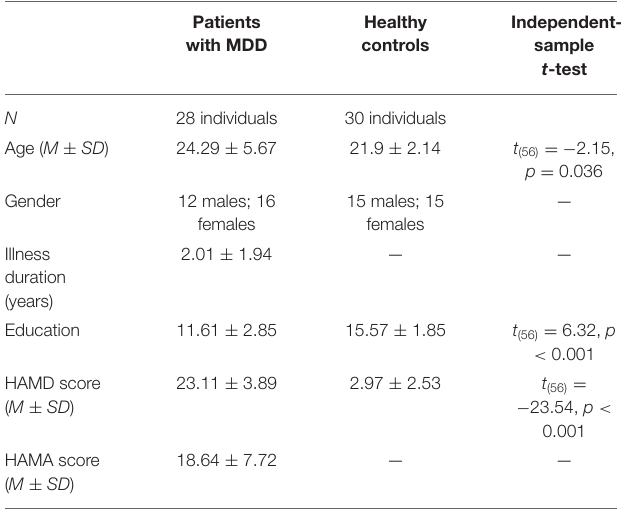
TABLE 1 | Demographic and clinical information of major depressive disorder (MDD) patients and healthy controls. Patients with